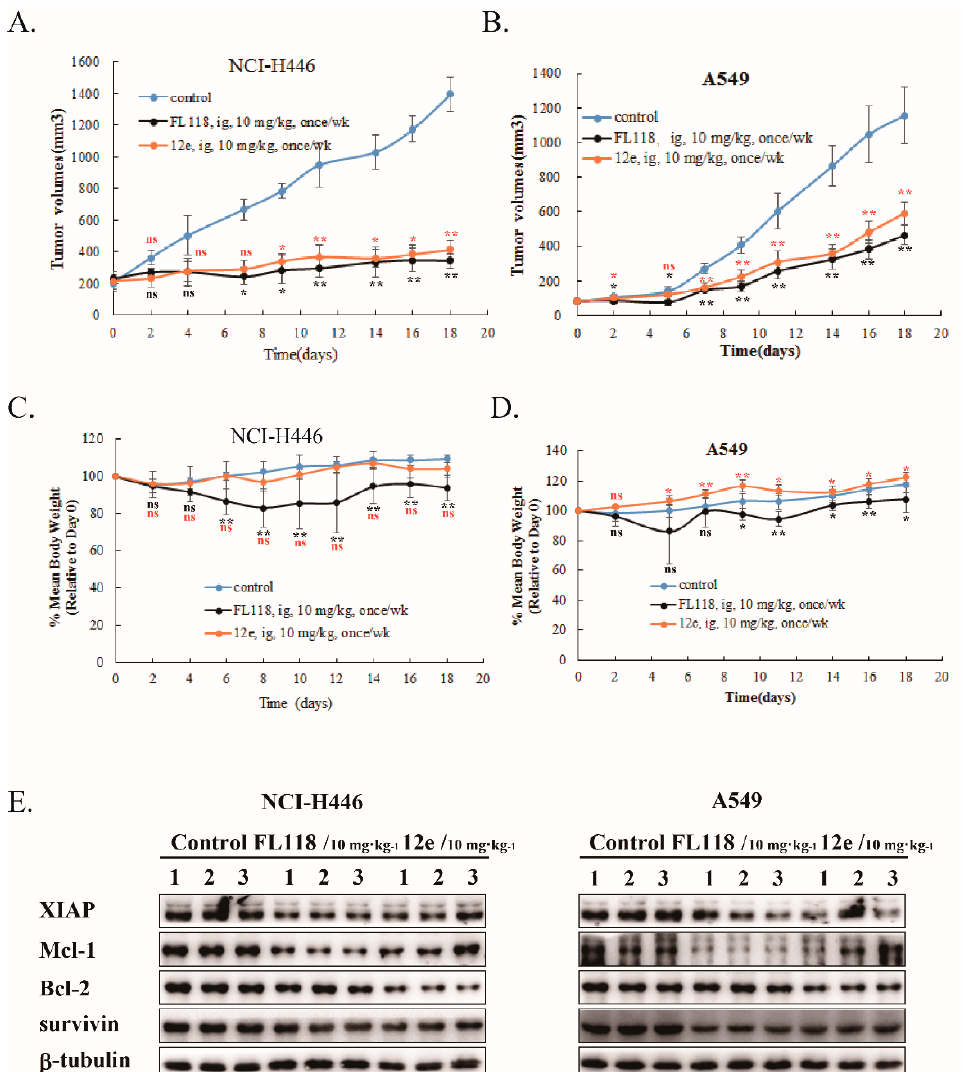
Figure 6. 12e suppresses tumor growth in vivo. A549 or NCI-H446 bearing mice were intragastrically administrated with FL118, 12e or vehicle, and the tumor volumes and body weights of mice were determined. ( A ) The tumor volumes of A549 xenografts. ( B ) The tumor volumes of NCI-H446 xenografts. ( C ) Body weights of A549 bearing mice. ( D ) Body weights of NCI-H446 bearing mice. ( E ) Western blotting analyzes the expression levels of survivin, Bcl-2, Mcl-1and XIAP in the excised tumor tissues. β -tubulin was chosen as the internal control. * p < 0.05, ** p < 0.01 vs. control.